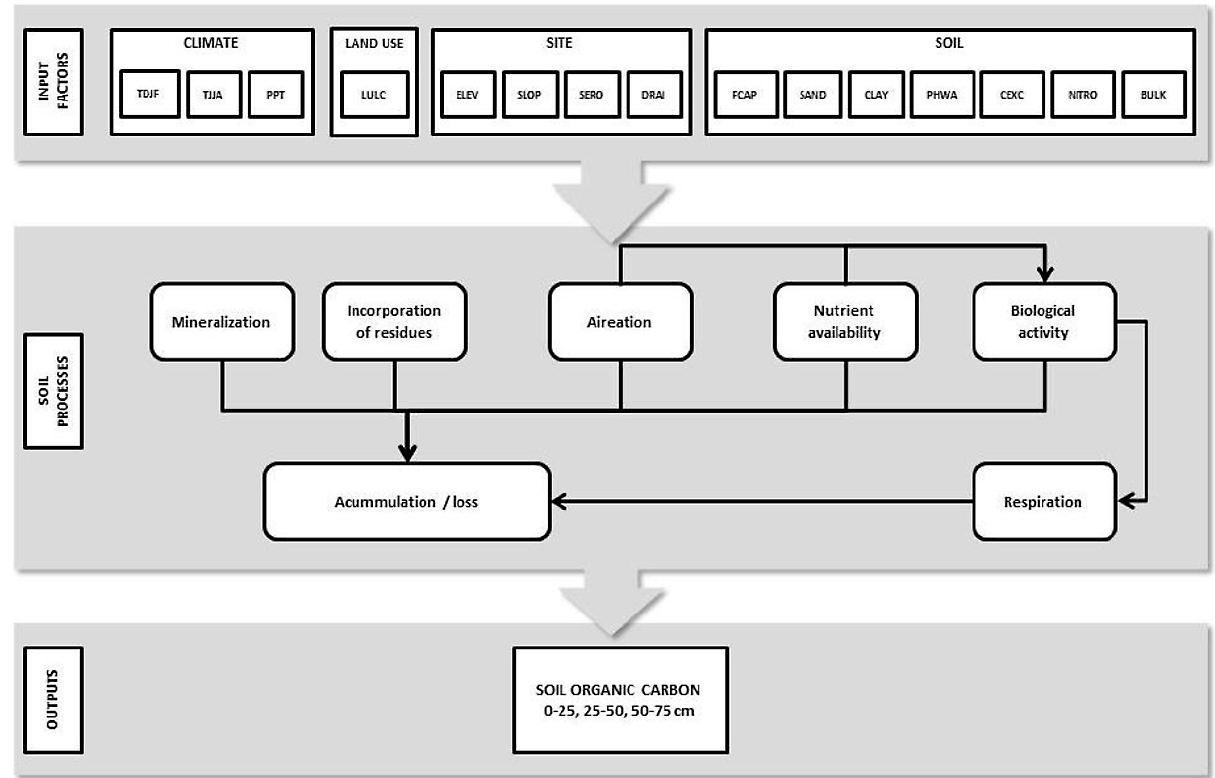
Fig. 2. General diagram of the CarboSOIL model: input factors. simulated soil processes and outputs. Input factor abbreviations are described in Table